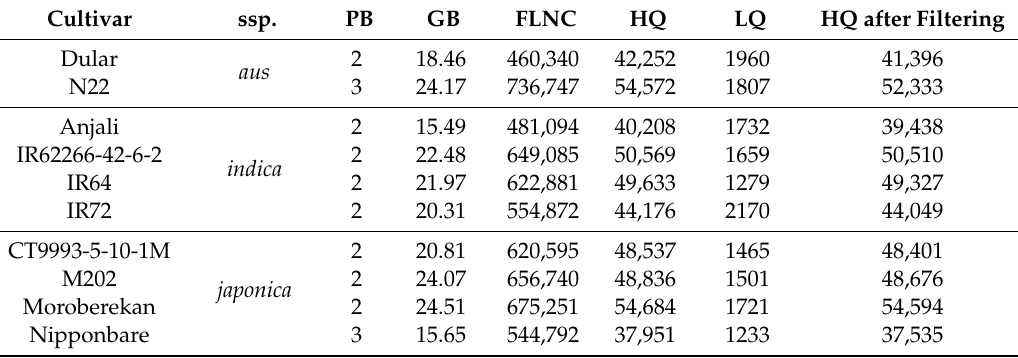
Table 2. Overview of results from PacBio full-length isoform sequencing from ten Oryza sativa L. ( Poaceae ) cultivars. Identified high (HQ) and low quality (LQ) isoforms were analyzed for non-plant contamination using blast. Contaminating sequences (not in the group of Viridiplantae ) were removed (HQ after filtering). PB—number of PacBio SMRT cells, GB—total number of sequenced base pairs in gigabases, FLNC—full-length non-chimeric reads. Cultivars were sorted alphabetically within the subspecies (ssp.) aus , indica and japonica .